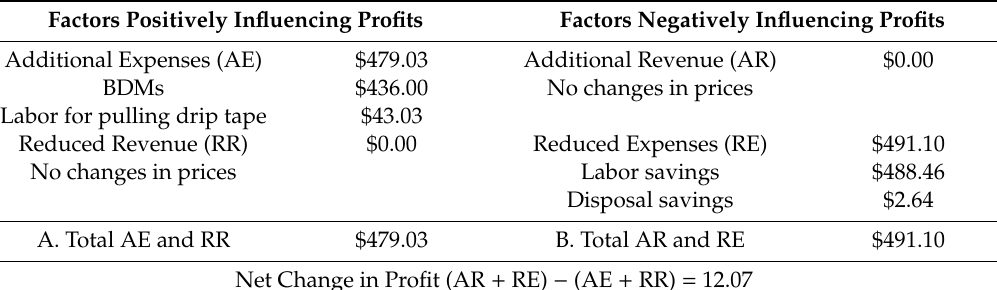
Table 5. Net changes in profit per hectare associated with the adoption of